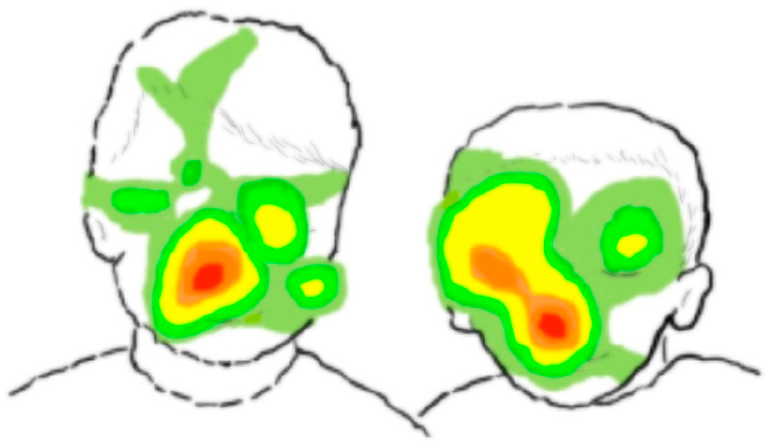
Figure 1. Density of the fixation duration when children watched a picture of two children.